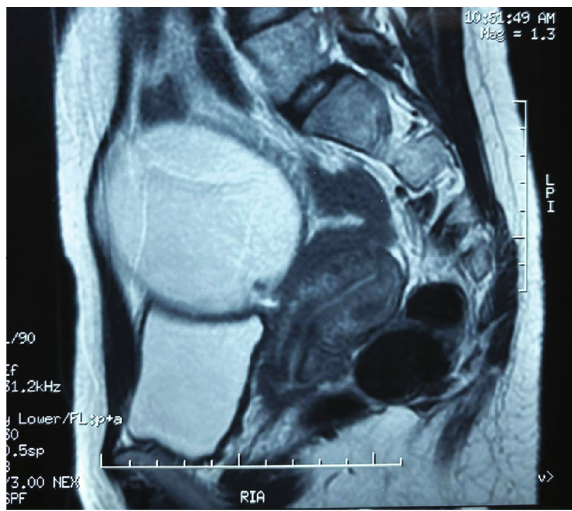
Figure 2: Magnetic resonance imaging showing abdominopelvic mass.